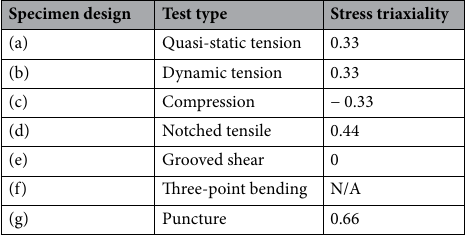
Table 1. Summary of material experiments and associated stress